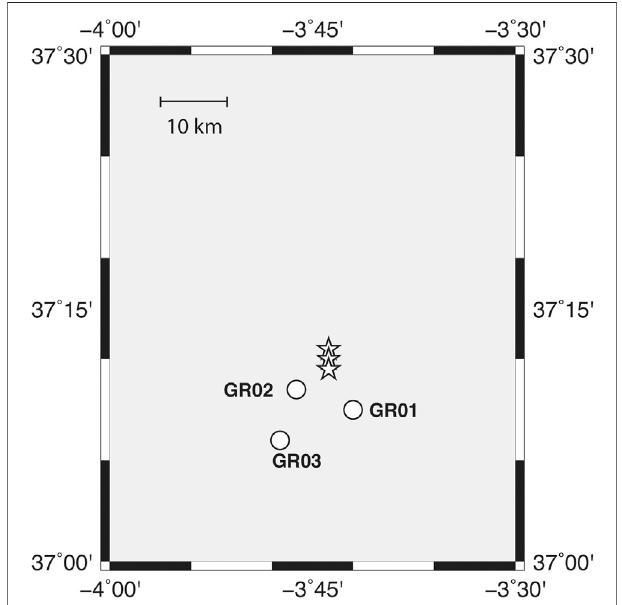
FIGURE6| PRESTo fi nalepicenters(whitecircles)andIGN(whitestars).